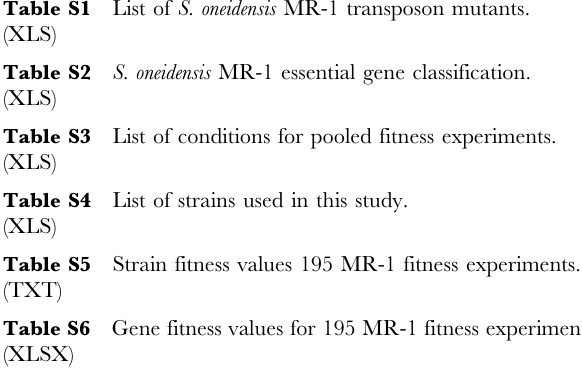
Table S7 Z scores for 195 MR-1 fitness experiments. Table S8 List of primers used in this study. Table S9 List of plasmids used in this